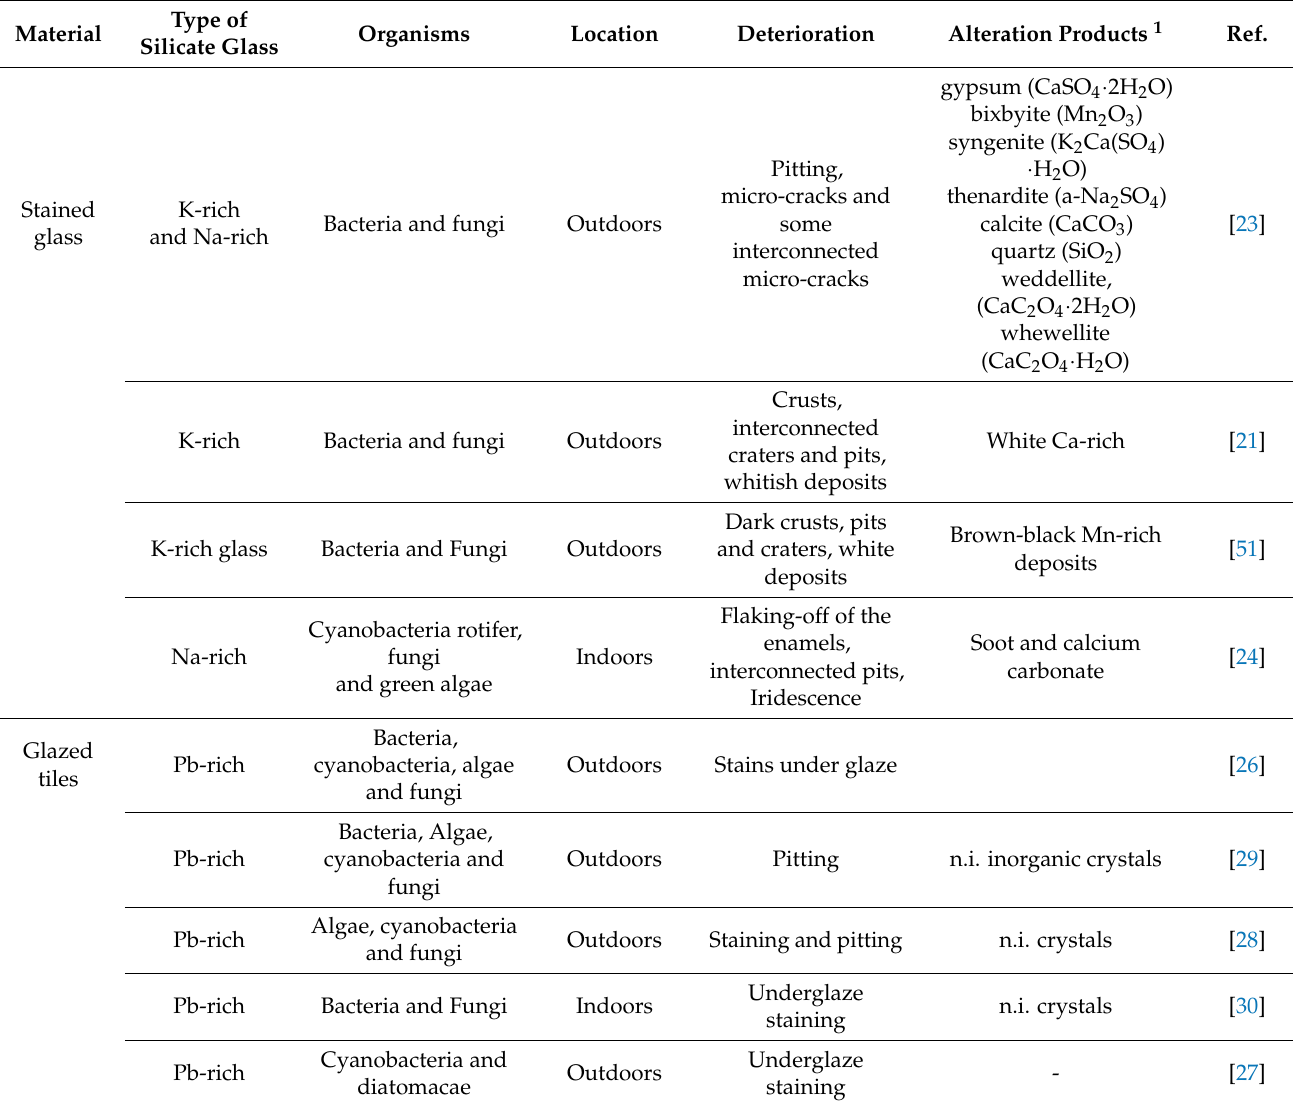
Table 2. Main biodeterioration patterns and alteration products identified on case studies on stained glass and glaze tiles from the 21st century